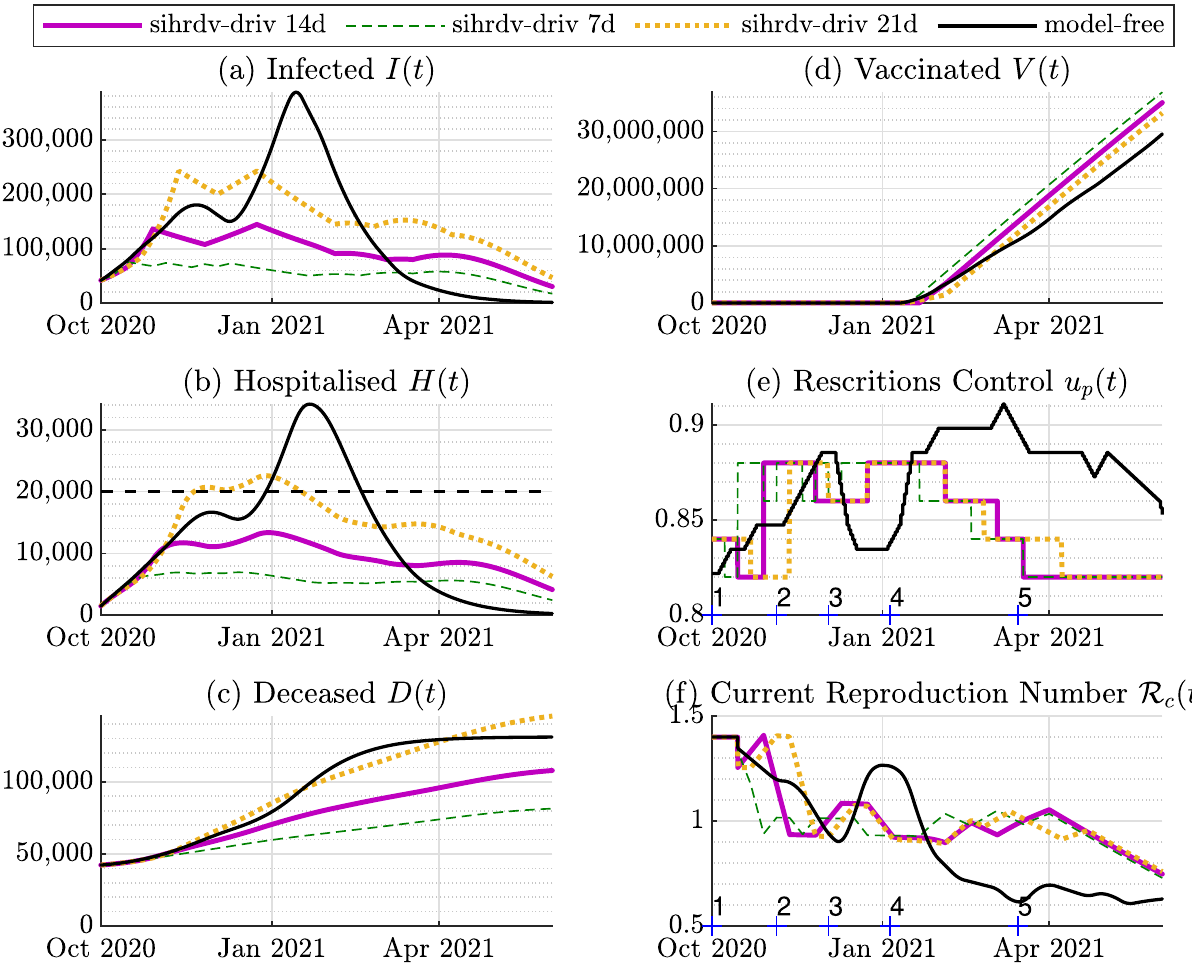
Figure 3. Time histories of the retrospective analysis: 1 October 2020-1 June 2021. The purple line represents our SIHRD-V model-driven results with a policy update of 14 days (sihrdv-driv 14d). We also include results with a policy update of 7 days (the green dashed line named sihrdv-driv 7d), and of 21 days the (orange dotted line named sihrdv-driv 21d). The black line represents the actual intervention policy followed in the UK. The black dashed line is desired upper limit for the hospitalisation (equal to 20,000). The hospitalised population remains below 20,000 if our intervention strategy is used. The numbers 1, 2, . . . , 5 on the horizontal axis in Sub- Figures ( e ) and ( f ) represent the instants when adjustments are taken in the model-free